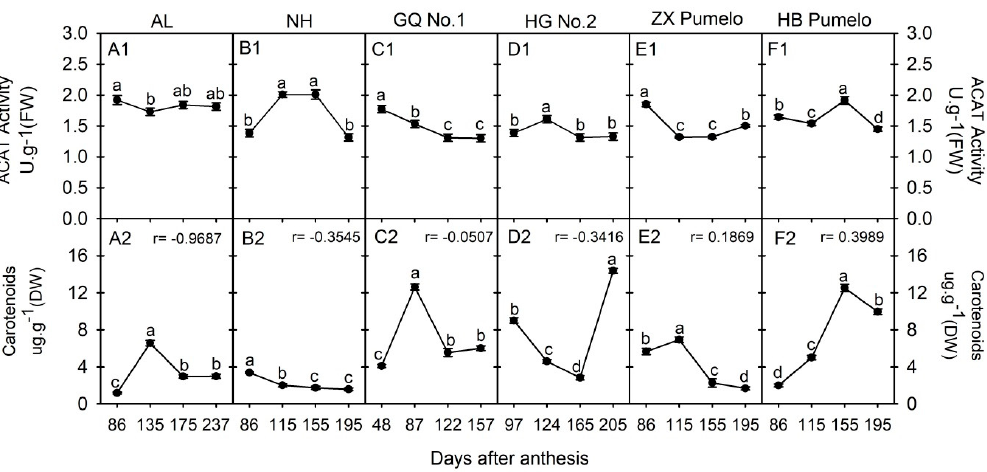
Figure 4. Changes of acetyl-CoA C-acetyltransferase (ACAT) activity ( A1~F1 ) and carotenoids concentration ( A2~F2 ) in the fruit juice sacs during fruit development and ripening of six citrus cultivars. AL refers to ‘Anliu’ orange. NH refers to ‘Newhall’ navel orange. GQ No. 1 refers to ‘Guoqing No. 1 ′ Satsuma mandarin. HG No. 2 refers to ‘Huagan No. 2 ′ ponkan. ZX pumelo refers to ‘Zaoxiang’ pumelo. HB pumelo refers to ‘HB’ pumelo. Different lowercase letters on the bar in each graph indicate significant di ff erences at p < 0.05 among samples at di ff erent stages by Duncan’s multiple range test. r refers to the correlation coe ffi cient between the carotenoid concentration and the ACTA activity in each